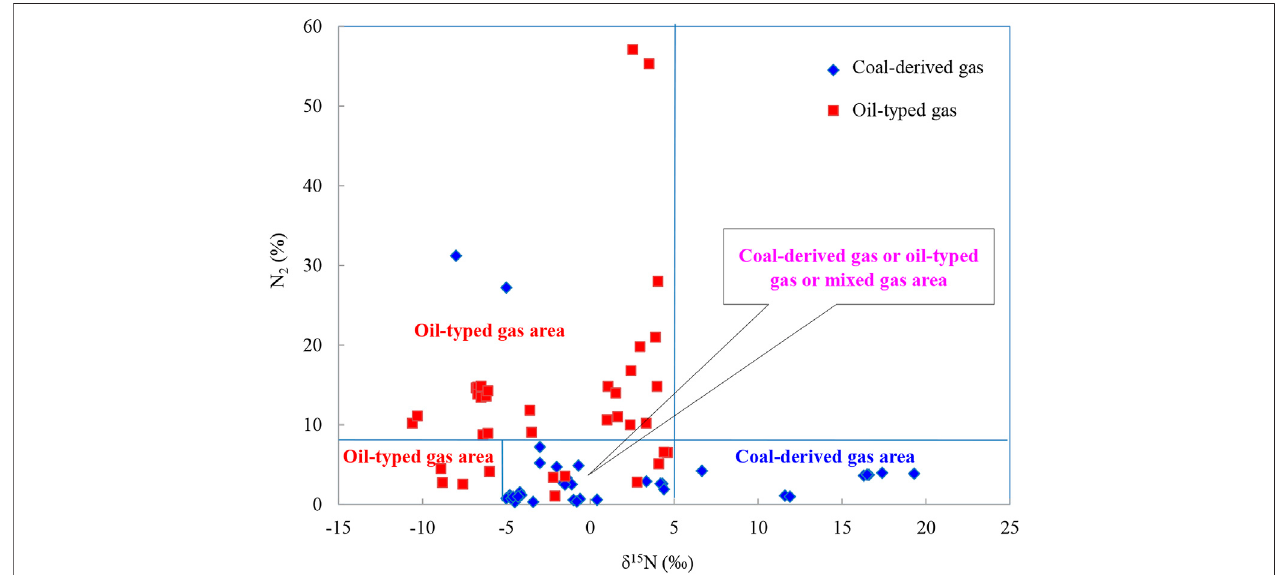
FIGURE 8 | Chart of R/Ra- δ 15 N for identifying sources of nitrogen in natural gases.